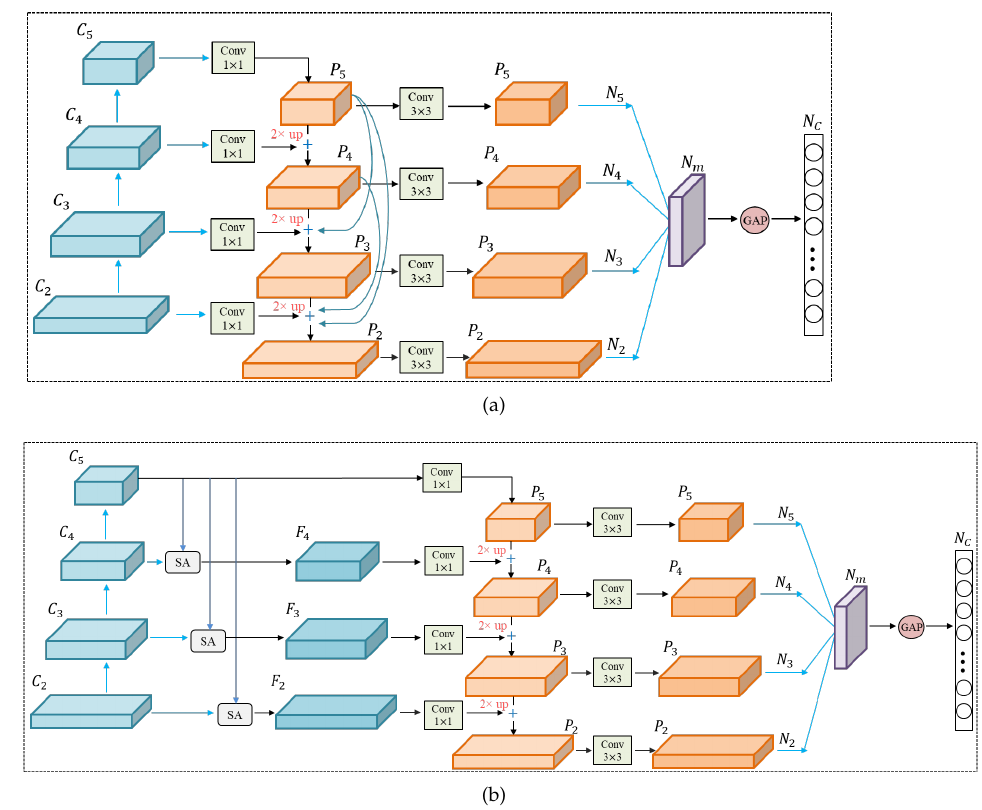
Figure 13. The structures without spatial attention ( a ) and without cross-scale cascade ( b